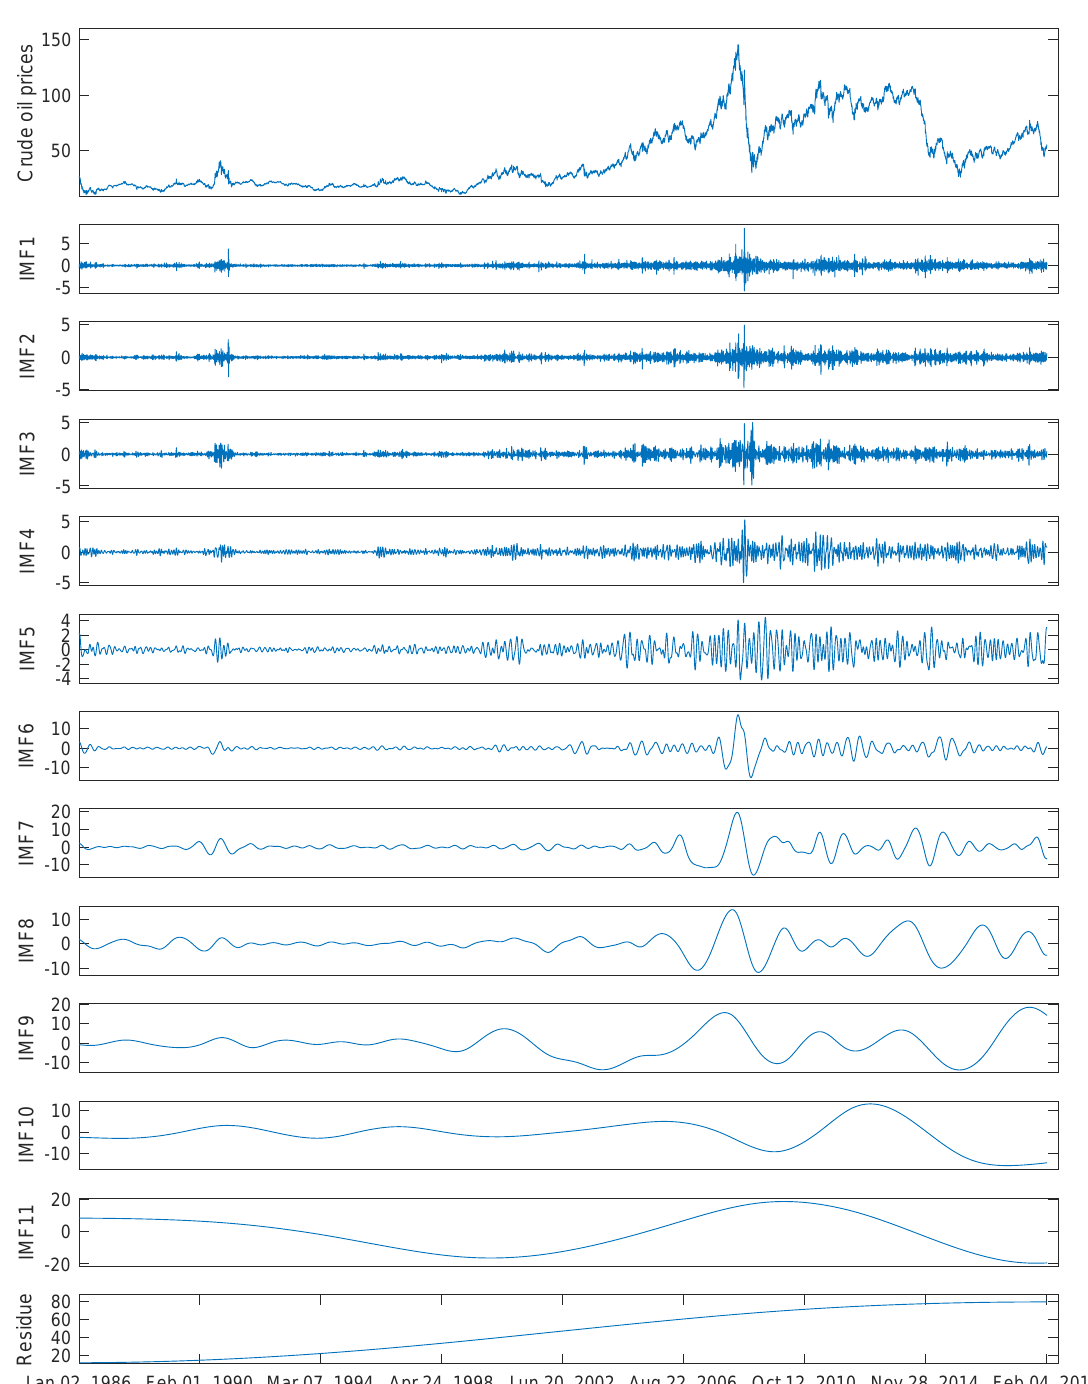
Figure 2. The daily WTI crude oil prices and the corresponding decomposed components by